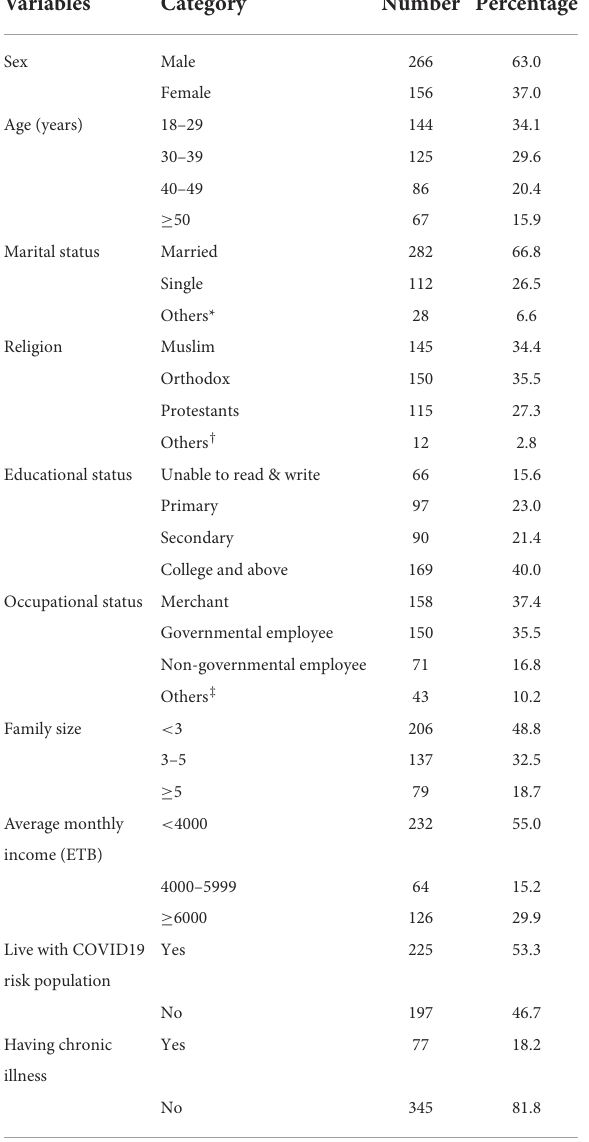
TABLE 2 Socio-demographic characteristics of participants at Jimma town 2021, Jimma,